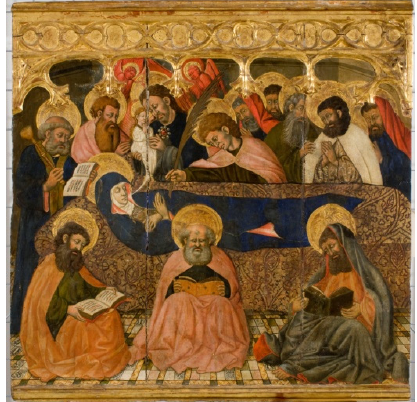
Figure 7. Second Maestro of Estopiñán, “Dormition of the Virgin”, ca. 1450, Museu Nacional d’Art de Catalunya (MNAC).